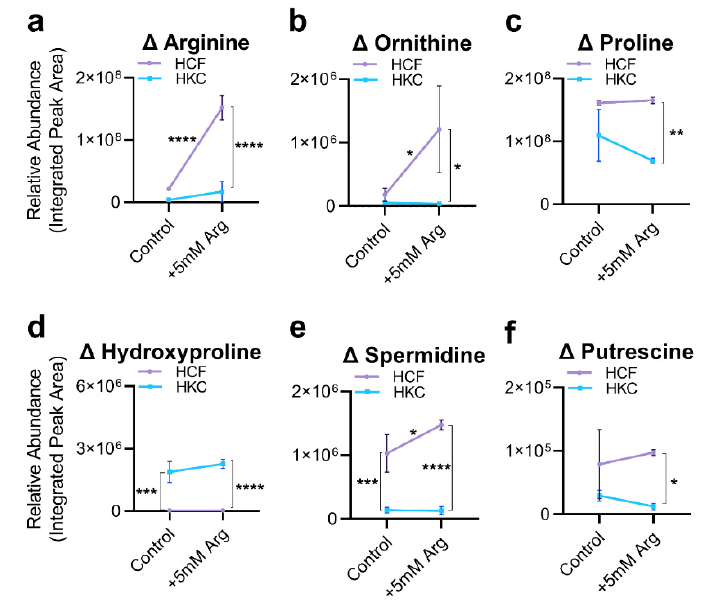
Figure 4. Arginine uptake and change in steady-state levels of arginine-related metabolites in HCFs and HKCs following arginine supplementation (5 mM). Relative abundance of ( a ) arginine, ( b ) ornithine, ( c ) proline, ( d ) hydroxyproline, ( e ) spermidine, and ( f ) putrescine in control and arginine supplemented (5 mM) constructs. Baseline control levels for these metabolites are also shown in Figure 2. Statistical significance assessed using a two-way ANOVA with Sidak’s multiple comparisons and * p < 0.05, ** p < 0.01, *** p < 0.001, and **** p < 0.0001 based on n = 3. Error bars represent standard deviation.